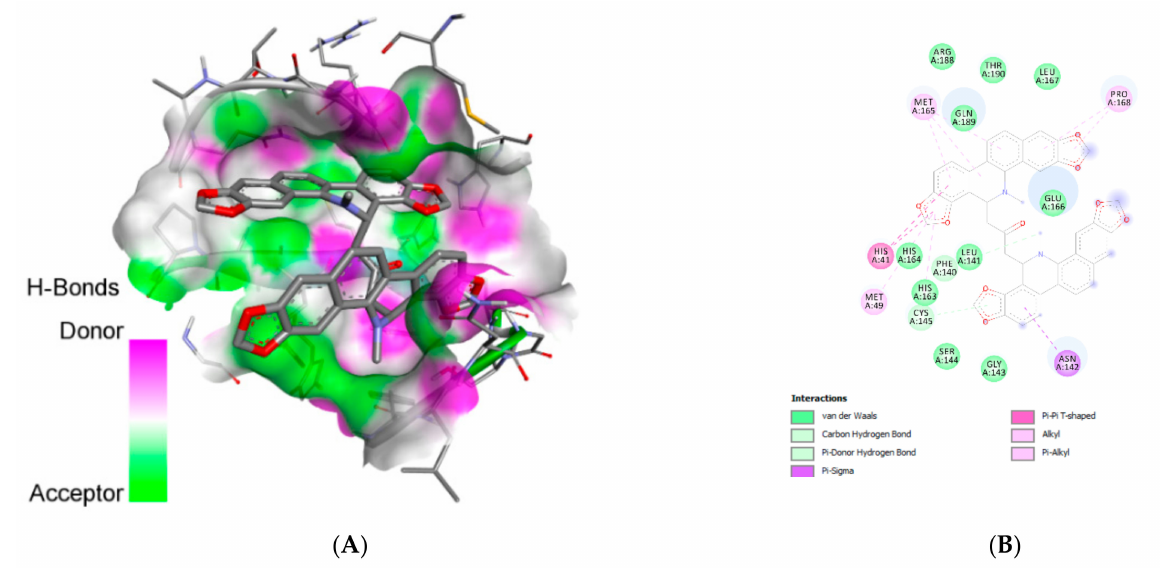
Figure 1. Three-dimensional ( A ) and two-dimensional ( B ) diagrams depicting the interaction of chelidimerine with the amino acid residues of the main protease (6LU7).